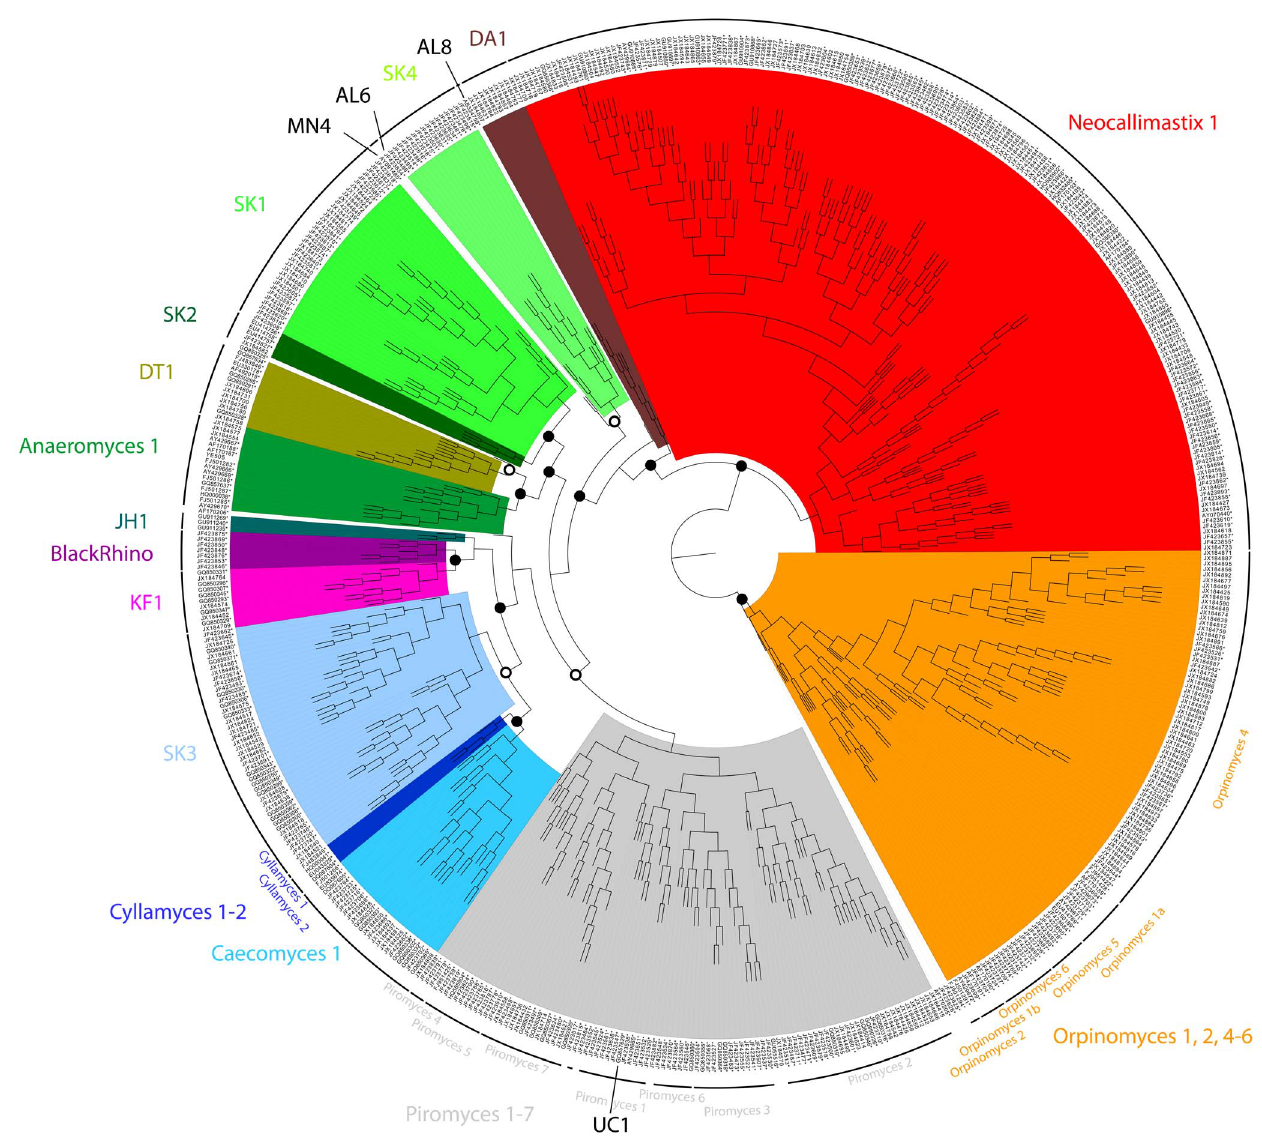
Figure 4. Profile Neighbor Joining tree of neocallimastigomycete ITS1 sequences. Profile Neighbor Joining tree calculated using sequence and structure data from 1120 (575 unique) complete neocallimastigomycete ITS1 sequences with 1000 bootstrap replicates in 29 iterations. Open circles indicate bootstrap values in a range of 50 to 90, closed circles indicate a bootstrap value above 90, and the scale bar indicates the distance. The tree contains the six known genera Anaeromyces , Caecomyces , Cyllamyces , Neocallimastix , Orpinomyces and Piromyces . and the unclassified sequences GQ850325, AF170206 and AF170205. Other monophyletic groups are highlighted and named according to Kittelmann et al. [10]. A total of ten sequences did not cluster into any of the defined groups and were named according to their accession numbers only (JF423517, JF423484, JF423882, GU055516, JX184570, JF423626, JF423625, GQ850325, AF170205, and AF170206). Sequences, accession numbers and taxonomic classifications (including definitions of subclusters of the genera Cyllamyces , Orpinomyces and Piromyces ) are available from the taxonomy file (File S2). Subcluster Orpinomyces 3 is not represented in this tree due to the lack of full-length ITS1 sequences for this group. A comparison of bootstrap values from this study to the sequence–only analysis of Kittelmann et al. [10] is given in Table S1. YE505 = Anaeromyces mucronatus YE505.